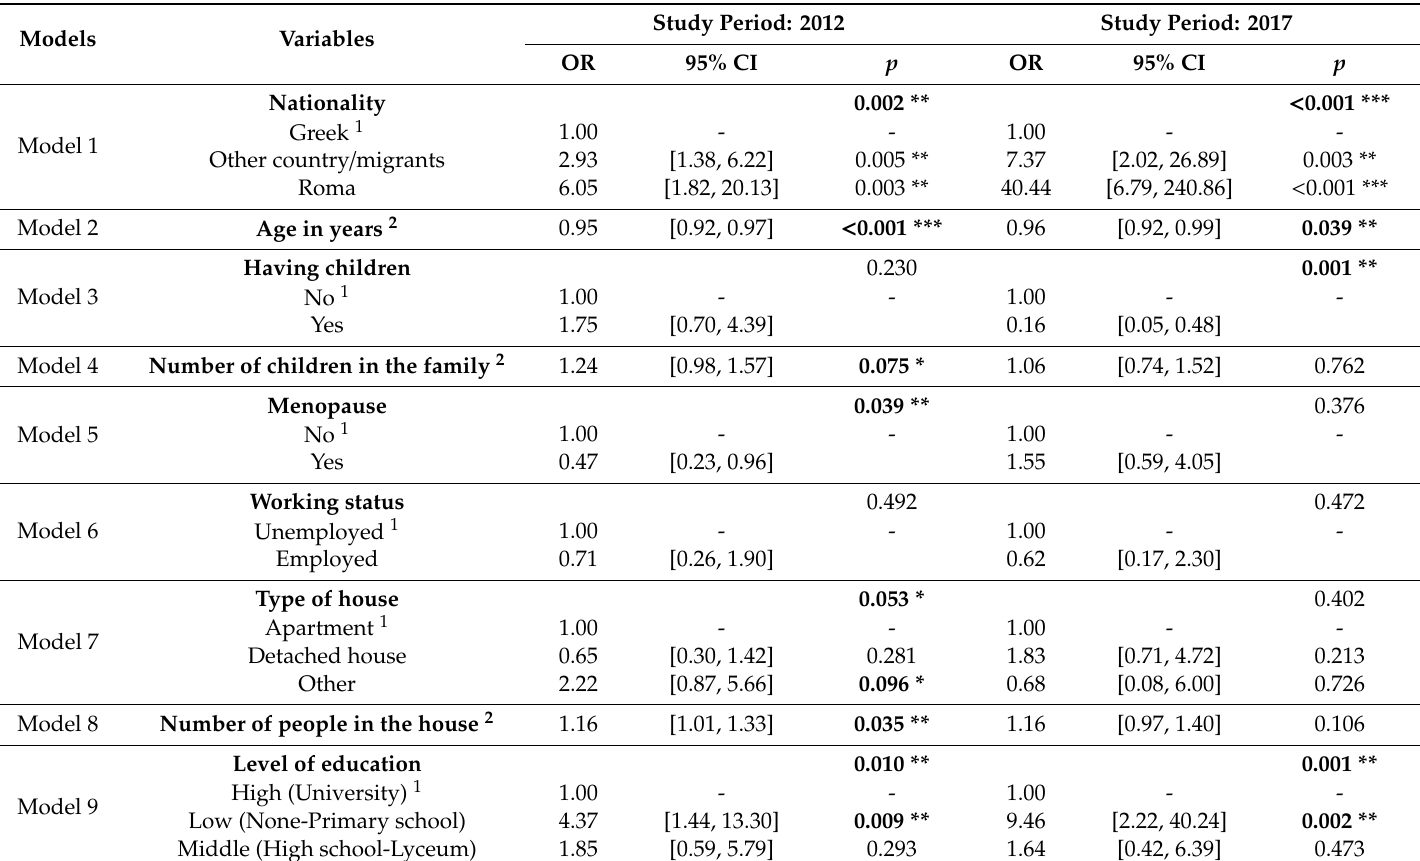
Table 2. Odds Ratio, 95% Confidence Intervals and the corresponding level of statistical significance concerning the e ff ect of women’s characteristics on the likelihood they had never undergone a Pap test for each study